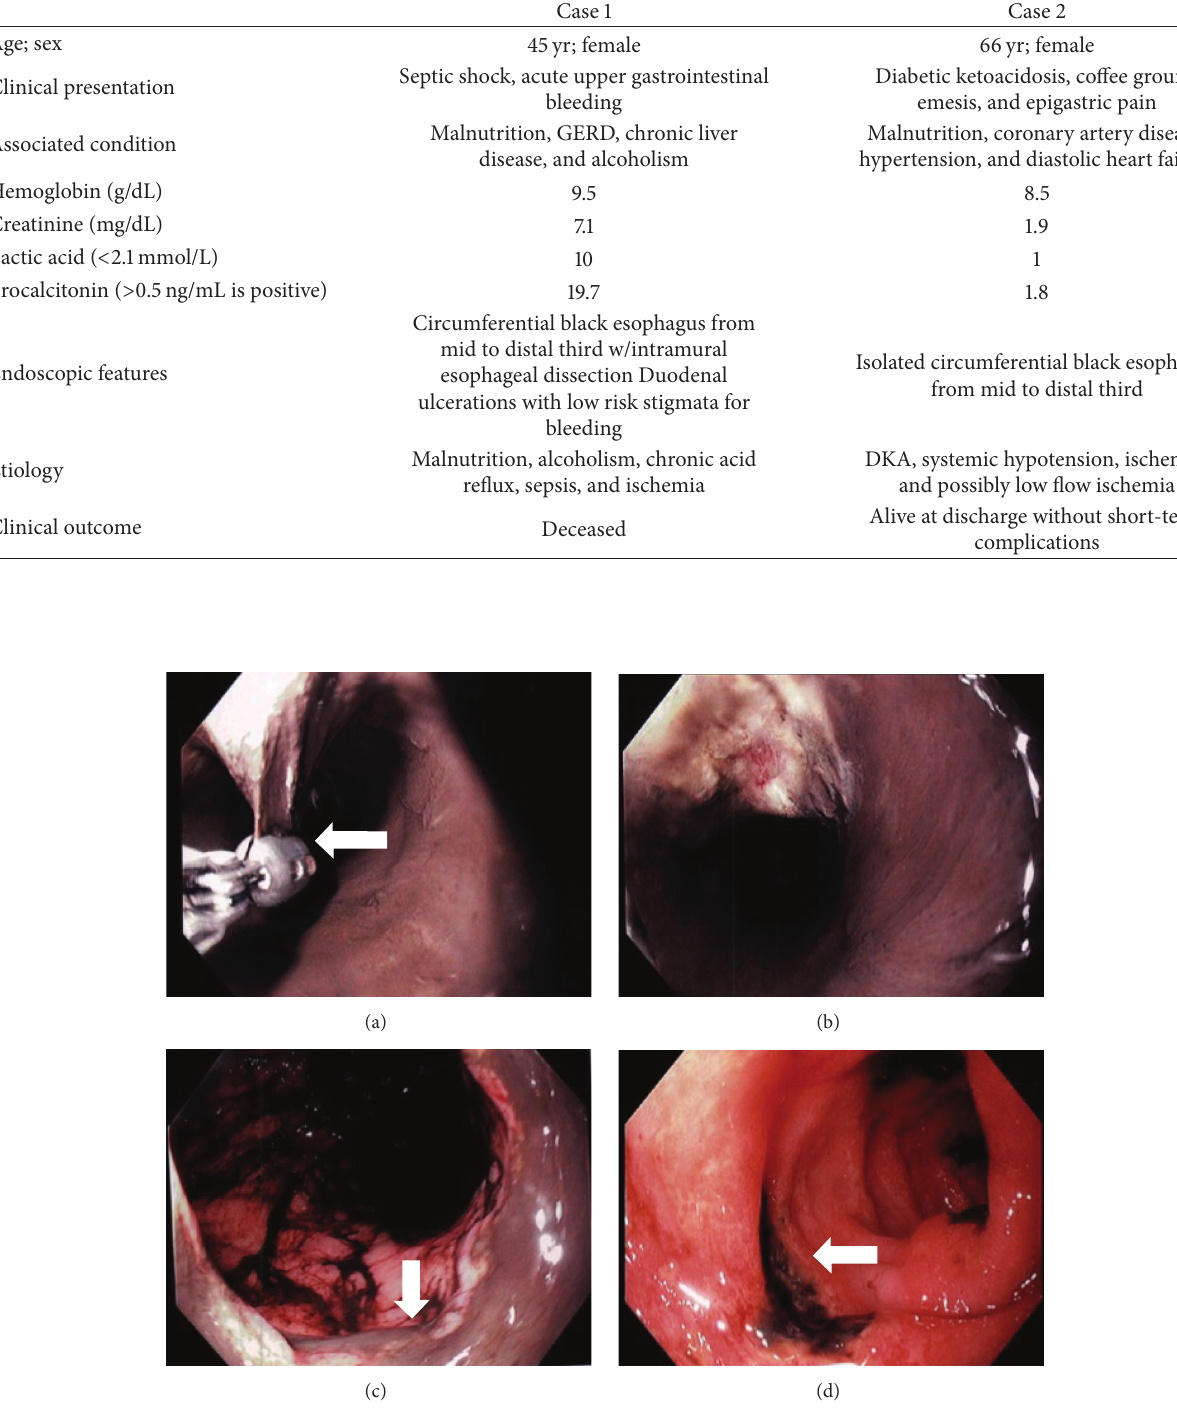
Figure 1: Images demonstrating diffuse mucosal necrosis extending from the mid to distal esophagus in circumferential fashion. A biopsy forcepsshowingmucosaldissection(ULmarkedwitharrow)withexposurethemusclelayer(UR).Stomachdemonstratingolddigestedblood throughout (LL) and discrete duodenal ulcers (LR marked with arrow) with ulcer base coated with blackish material suggesting ischemic